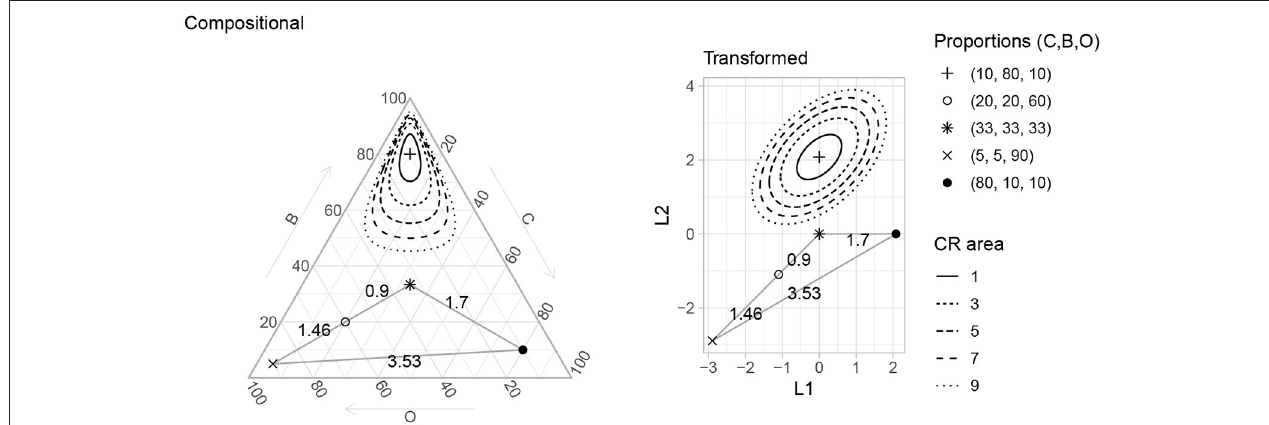
FIGURE 2 | Example of compositional distance (Equation 3) and area of confidence region (CRs) for a few selected points and sizes of CRs. Both the compositional data (left—C, Coniferous; B, Broad-leaved; O, Open land) and transformed [right— L 1 and L 2 are transformed compositional values from Equation (2)] are shown. Note that distances increase toward the edge of the compositional triangle (e.g., when one component goes to 0) due to the additive log